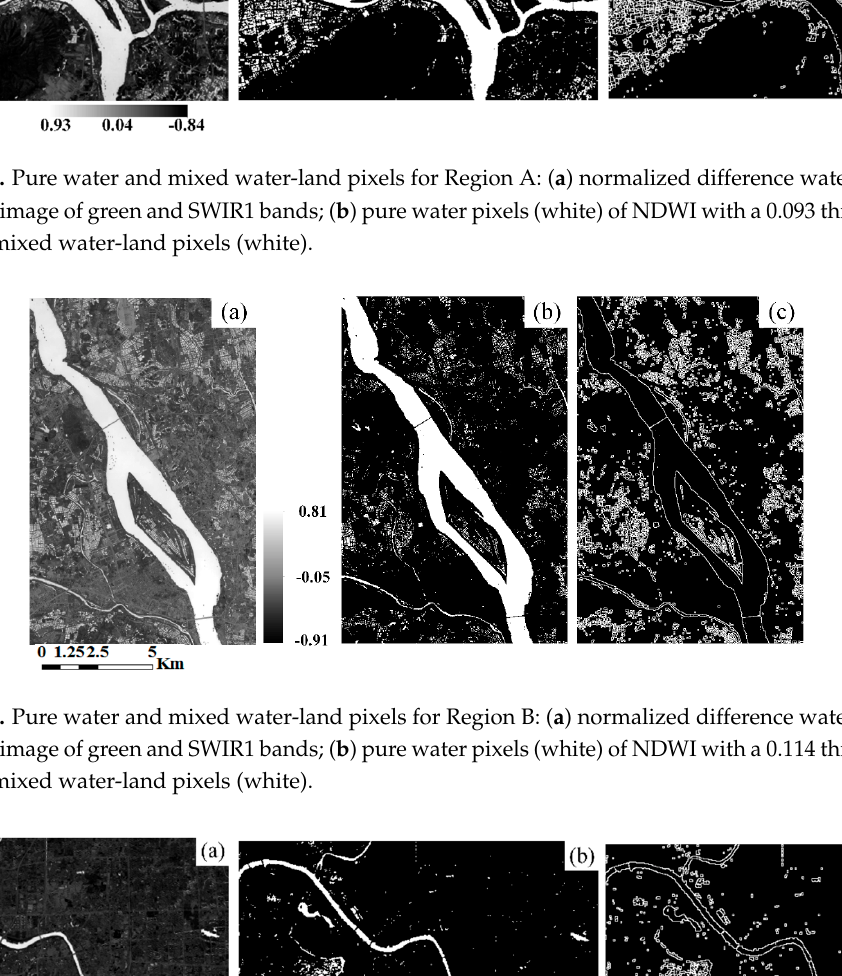
Figure 6. Pure water and mixed water-land pixels for Region D: ( a ) normalized difference water index (NDWI) image of green and SWIR1 bands; ( b ) pure water pixels (white) of NDWI with a 0.053 threshold; and ( c ) mixed water-land pixels (white).